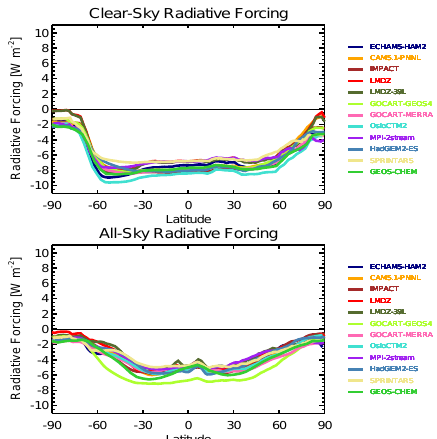
Fig. A3. Annual zonal-mean short-wave clear-sky and all-sky top-of-atmosphere radiative forcing between experiments with AOD=0.2 and AOD=0.0 distributed over the lowest two kilometers, holding SSA=1.0 and ANG=1.0 constant.